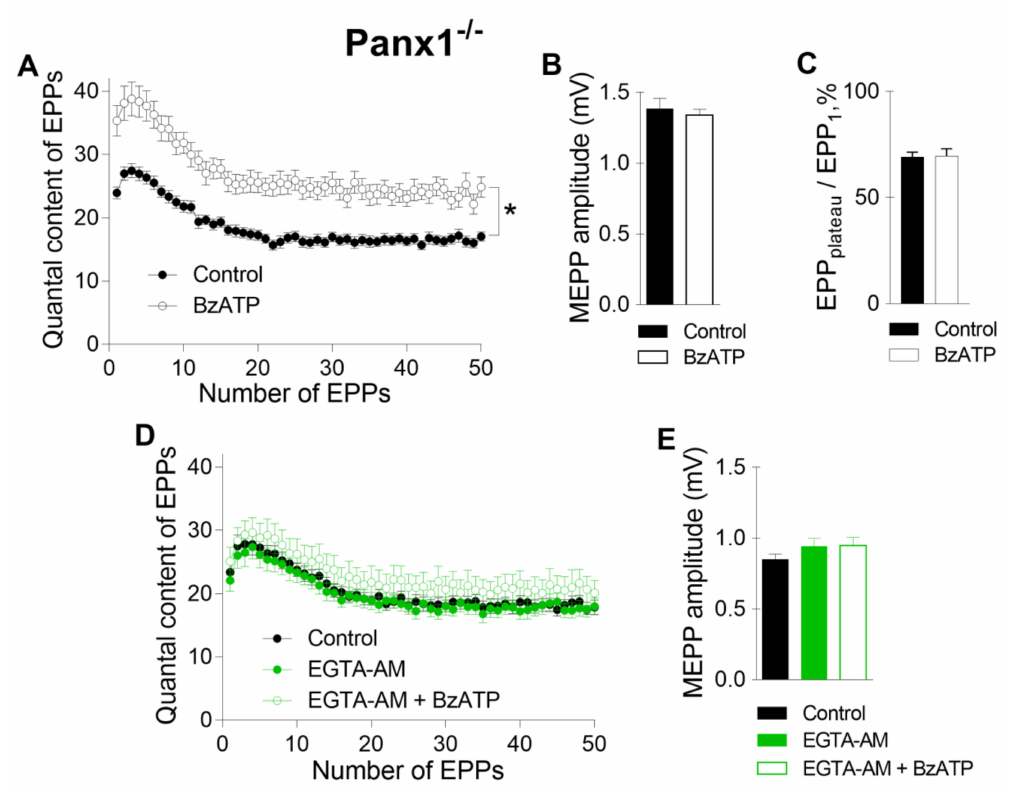
Figure 4. Intraterminal Ca 2 + bu ff ering with slow Ca2 + chelator prevented P2X7 receptor-mediated potentiation of evoked neuromuscular transmission at the NMJs of pannexin-1 knockout (Panx1 − / − ) mice during a short high-frequency EPP train (50 Hz, 1 s). ( A ) Changes in the EPP quantal content at the NMJs of Panx1 − / − mice in the control group (n = 19) and during the activation of P2X7 receptors by their agonist BzATP (30 µ M) (n = 15). ( B ) MEPP amplitude in the control group and upon application of BzATP. ( C ) The ratio of the average quantal content of the last ten EPPs in the train to the quantal content of the first EPP (EPP plateau / EPP 1 ) normalized to EPP 1 (taken as 100%) in the control group and during the application of BzATP. ( D ) Changes in the EPP quantal content at the NMJs of Panx1 − / − mice in the control group (n = 24), after incubation with EGTA-AM (50 µ M) (n = 20) and during the application of BzATP in the presence of preloaded EGTA (n = 15). ( E ) MEPP amplitude in the control group, after incubation with EGTA-AM and during the subsequent application of BzATP. The symbols, histograms and error bars represent the mean ± SEM. * p <